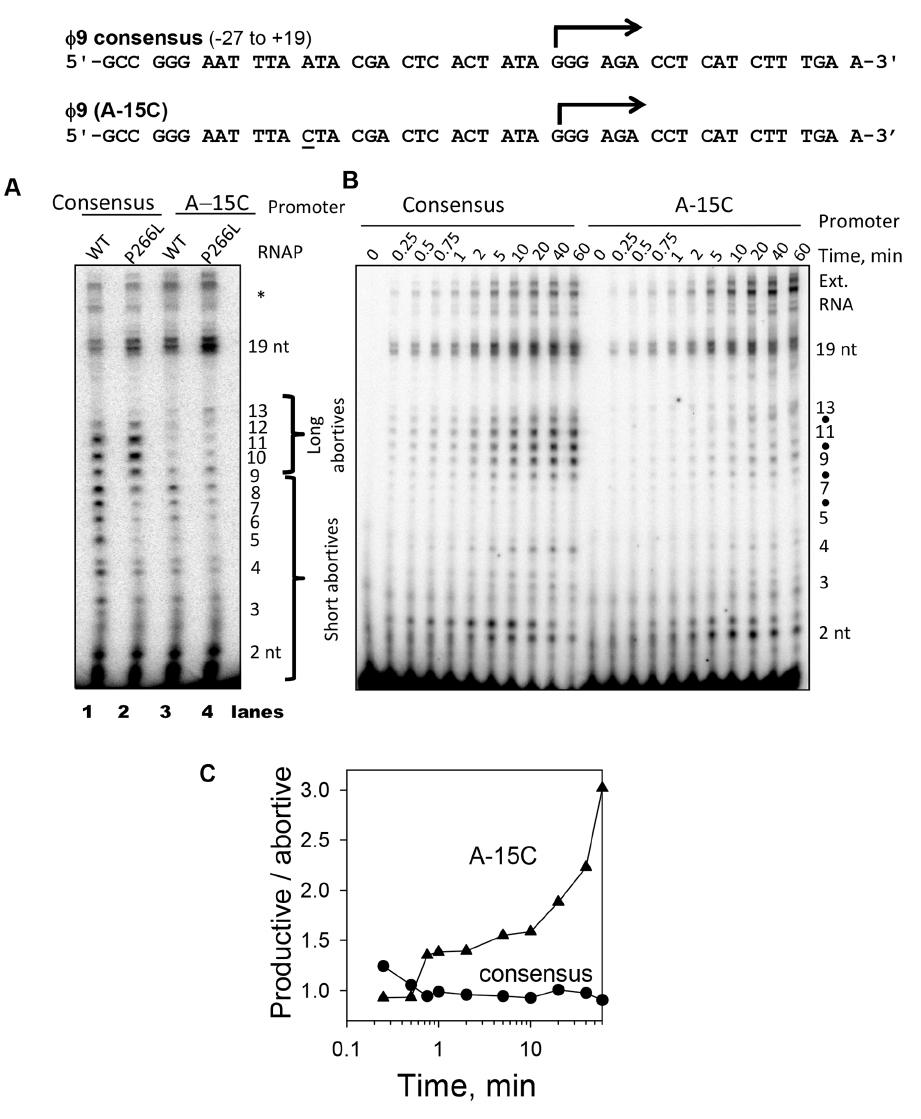
Figure 2. P266L mutation reduces short abortive without affecting the initial steps of transcription. (A) Transcription by WT or P266L T7 RNAP (5 m M) on the T7 Q 9 consensus or Q 9(A-15C) promoter (10 m M) was carried out at 25 u C for 1 min and products were resolved on a 23% sequencing gel and visualized by [ c - 32 P]GTP labeling. (B) Time course of transcription by P266L(15 m M) on consensus and A-15C promoter (10 m M). (C) The productive (runoff) to abortive ratio is higher when the P266L T7 RNAP is used in combination with the A-15C promoter mutant than with the consensus promoter. The productive to abortive ratio was obtained from data in (B).